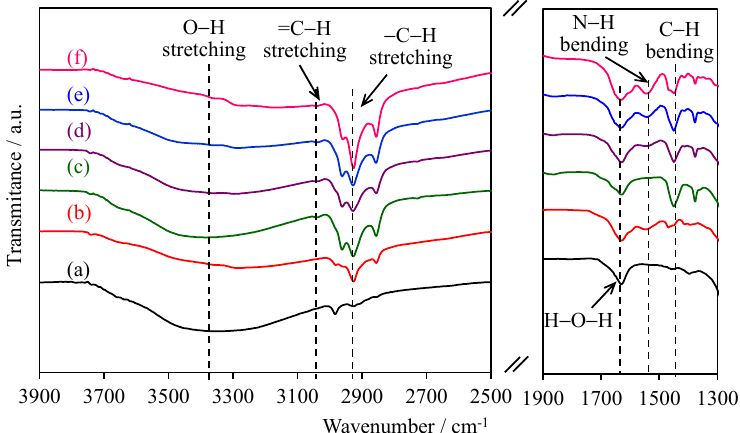
Figure 1. FTIR spectra of (a) WMS, (b) WMS-0.10, (c) NR/WMS, (d) NR/WMS-0.05, (e) NR/WMS- 0.10, and (f) NR/WMS-0.15.